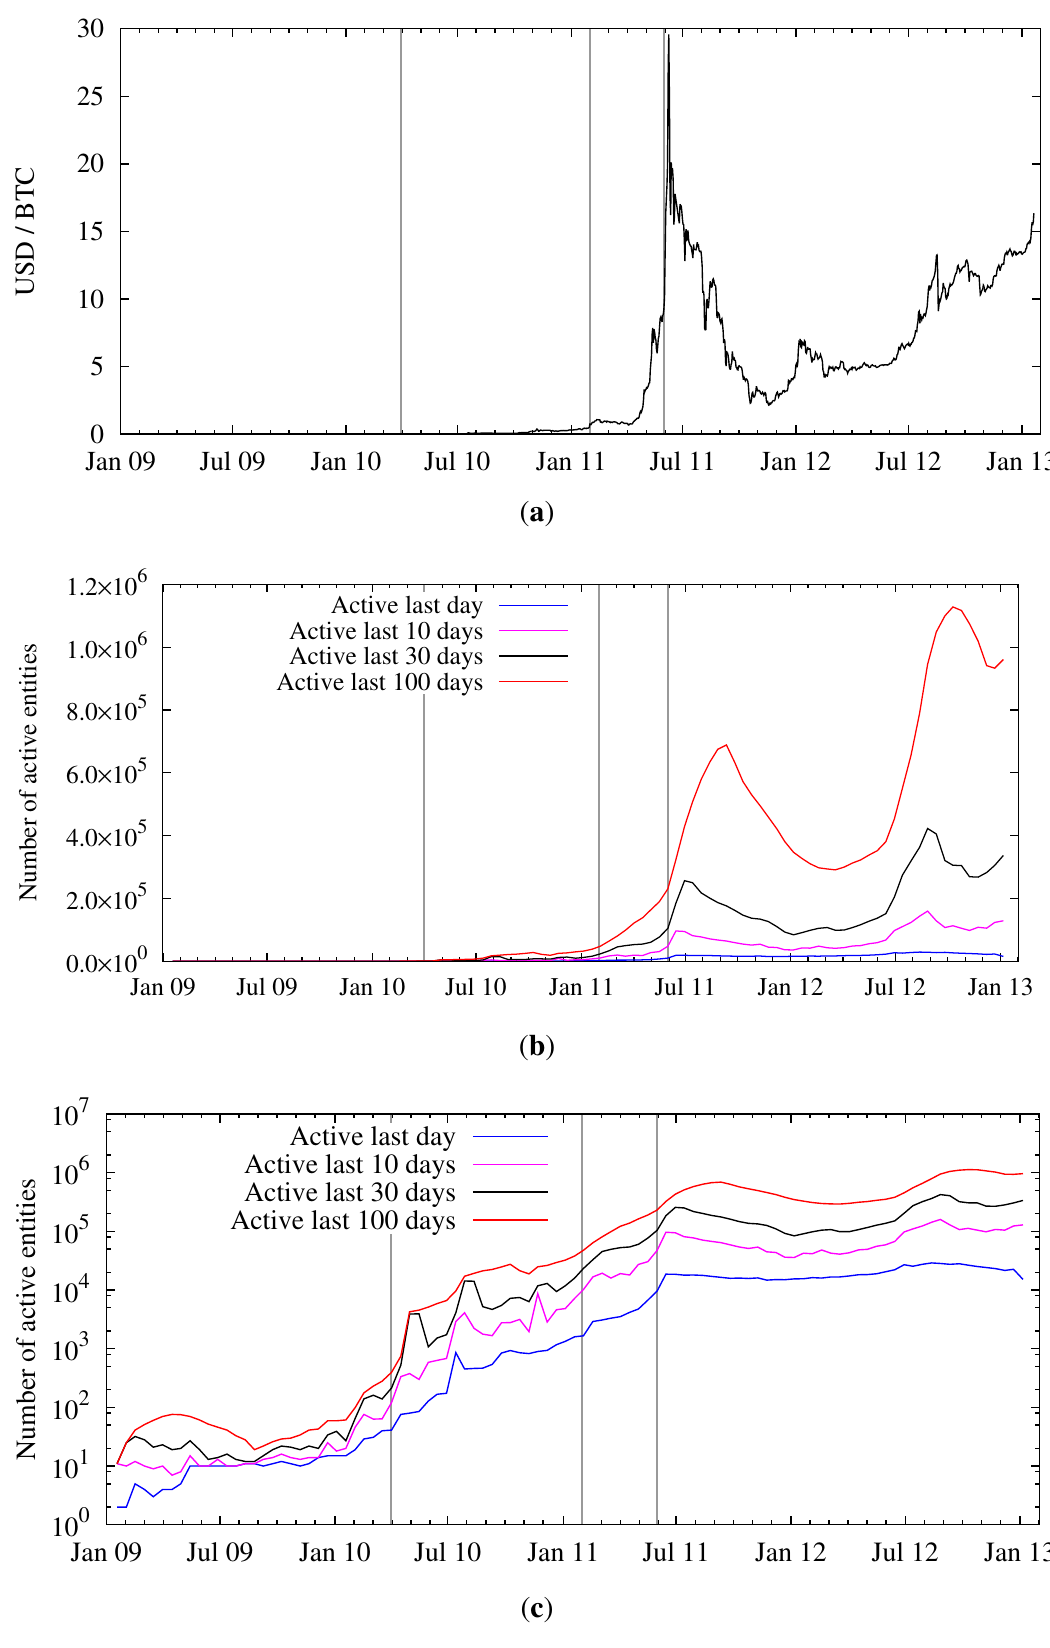
Figure 6. Price per bitcoin and activity of entities over time. ( a ) Exchange rate in USD at Mt. Gox (weighted average) [14]; ( b ) Entity activity over time (linear scale); ( c ) Entity activity over time (logarithmic